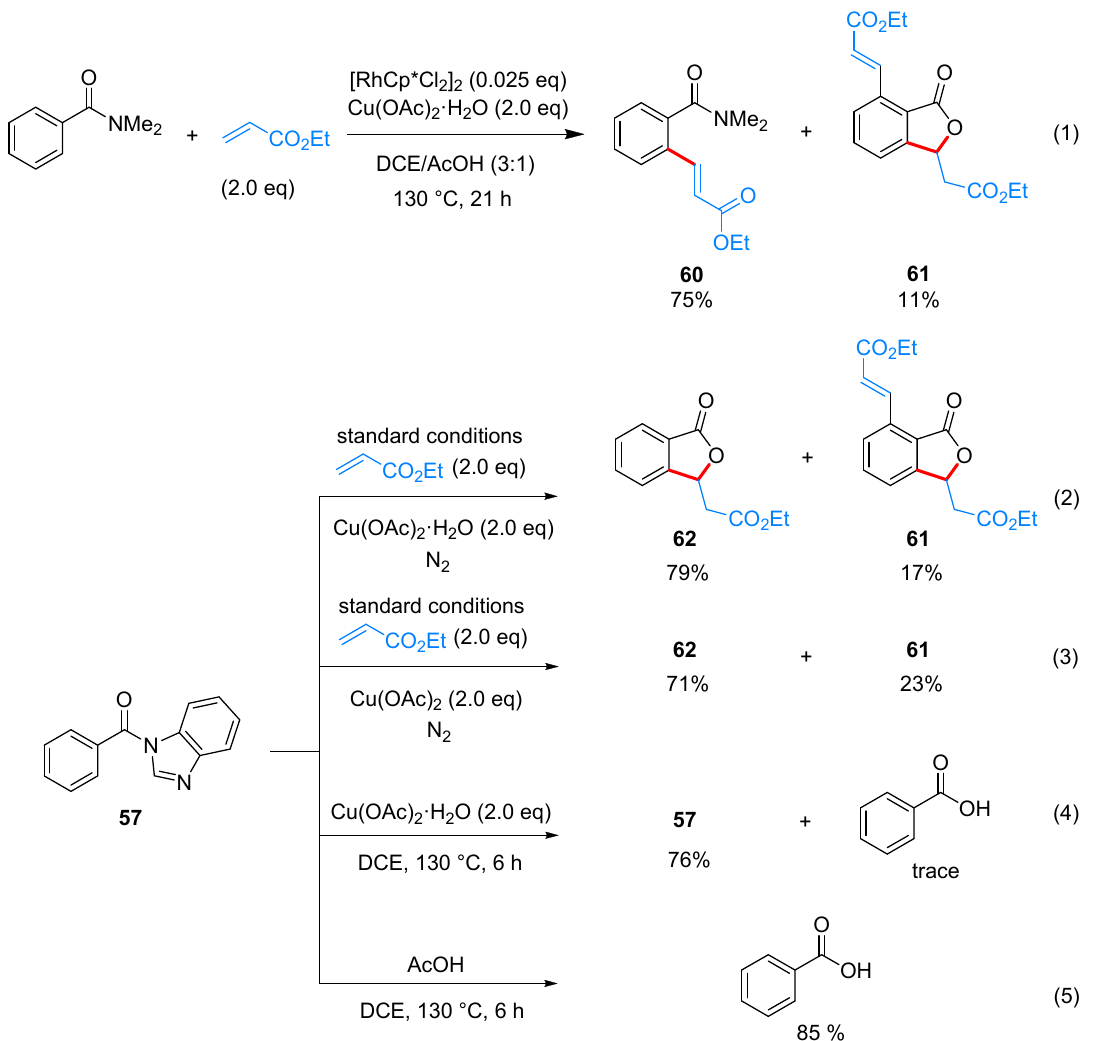
Scheme 33. Control experiments for the Rh-catalyzed annulative coupling of N -benzoyl benzimidazole and electrophilic alkenes.